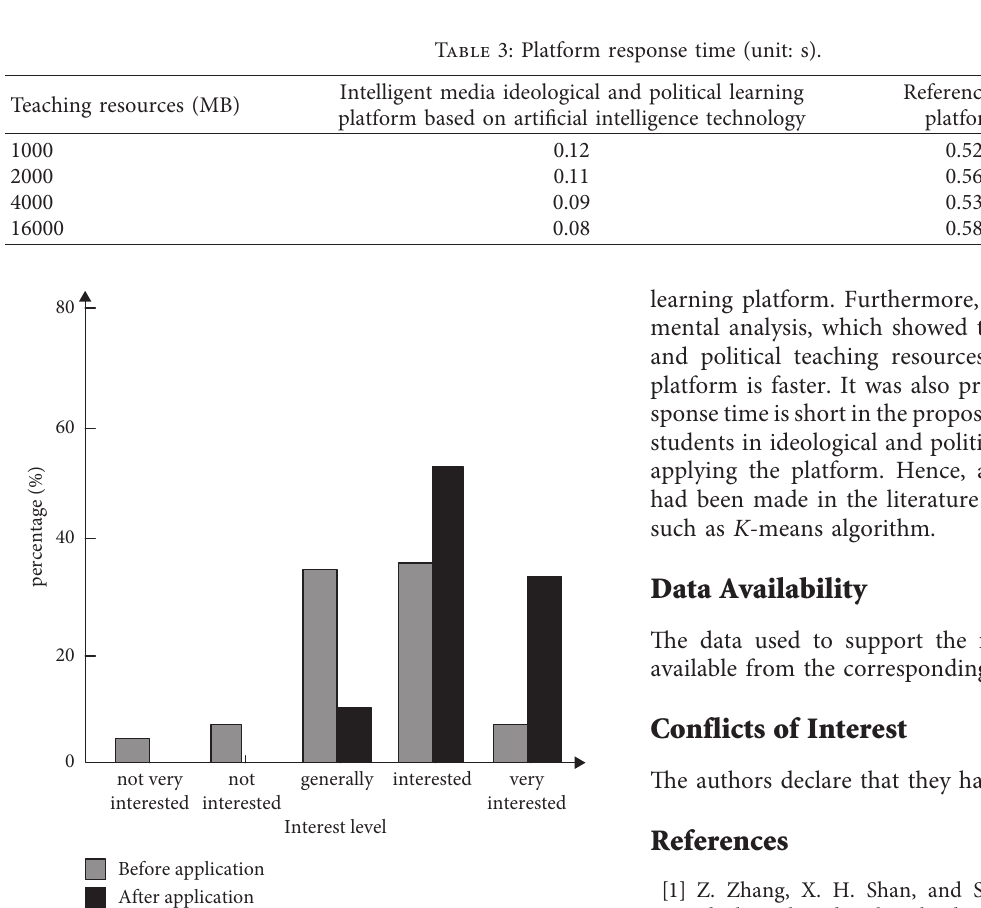
Figure 9: Statistical results of the degree of interest in ideological and political learning.